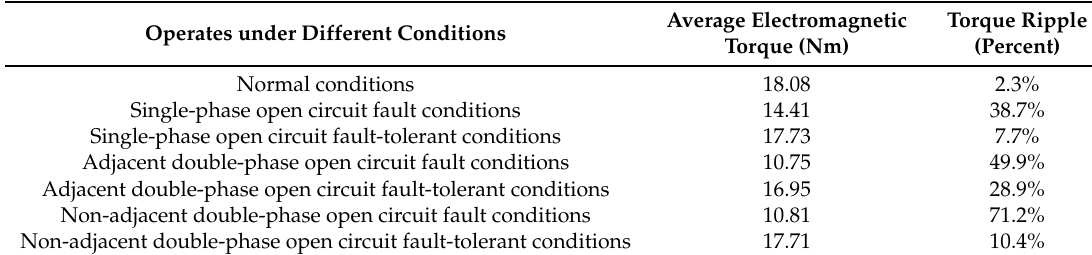
Table 4. The produced average electromagnetic torque and torque-ripple under different fault types when machine operates in series driven